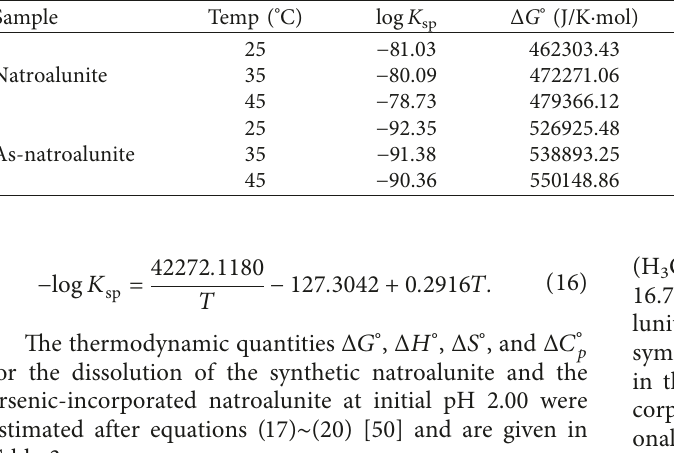
Table 3: Thermodynamic data of the natroalunite and the arsenic-incorporated natroalunite in aqueous acidic media (initial pH 2).